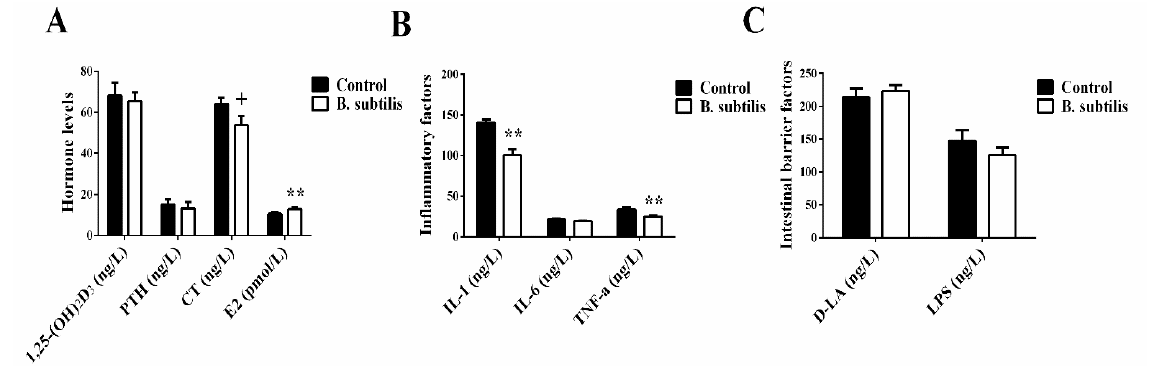
Figure 2. The effects of Bacillus subtilis on inflammatory factors, hormone levels, and intestinal barrier factors in laying hens at day 61. ( A ) Hormone levels in plasma. ( B ) Inflammatory factors concentrations in plasma. ( C ) Intestinal barrier factors concentrations in plasma. Data are presented as mean ± SEM ( n = 12 per group). ** means p ≤ 0.01; and + means 0.05 < p < 0.1. PTH: thyroid hormones; CT: calcitonin; E2: estrogen; IL-1: interleukin-1; IL-6: interleukin-6; TNF- α : tumor necrosis factor-alpha; D-LA: D-lactic acid; LPS: